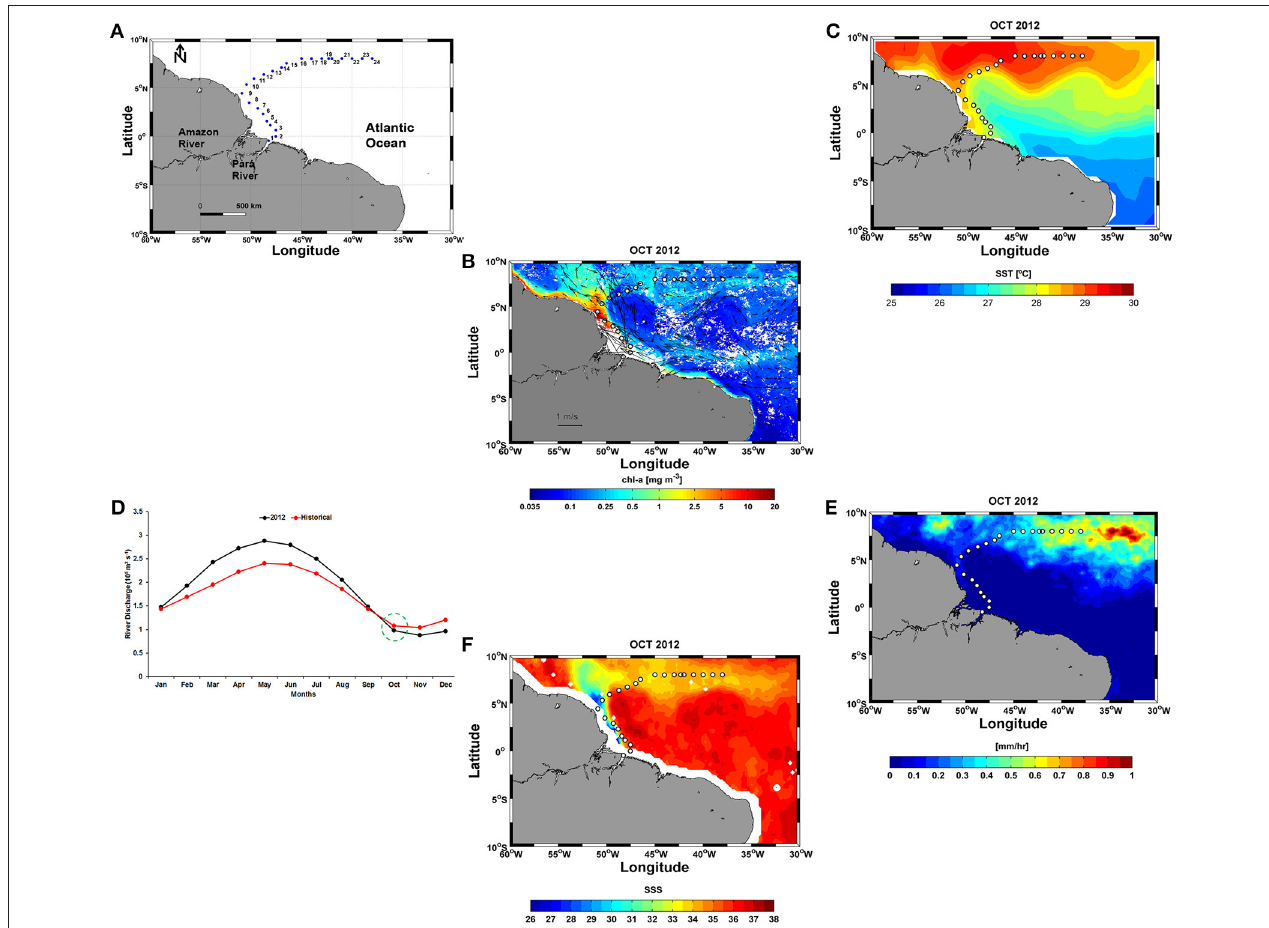
FIGURE 1 | (A) Positions of the 24 stations sampled along the ship track during the Camadas Finas III (CF3) cruise; (B) Sea surface currents (cm s − 1 ) and Chl-a (mg m − 3 ) in October 2012; (C) SST for the same period, obtained from Objectively Analyzed air-sea Fluxes (OAflux); (D) Monthly Amazon River discharge (m 3 s − 1 ) in October 2012 and climatology (1982–2012); (E) Monthly precipitation data sets (mm h − 1 ); and (F) SSS for October 2012 derived from the Soil Moisture and Ocean Salinity (SMOS).